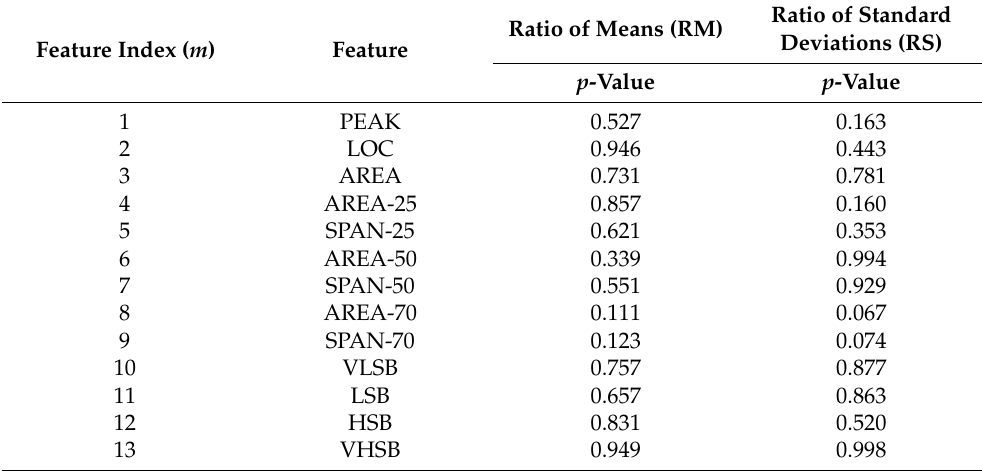
Table 5. List of temporal and spectral features extracted from ultrasonic envelopes for normal breathing ( N =